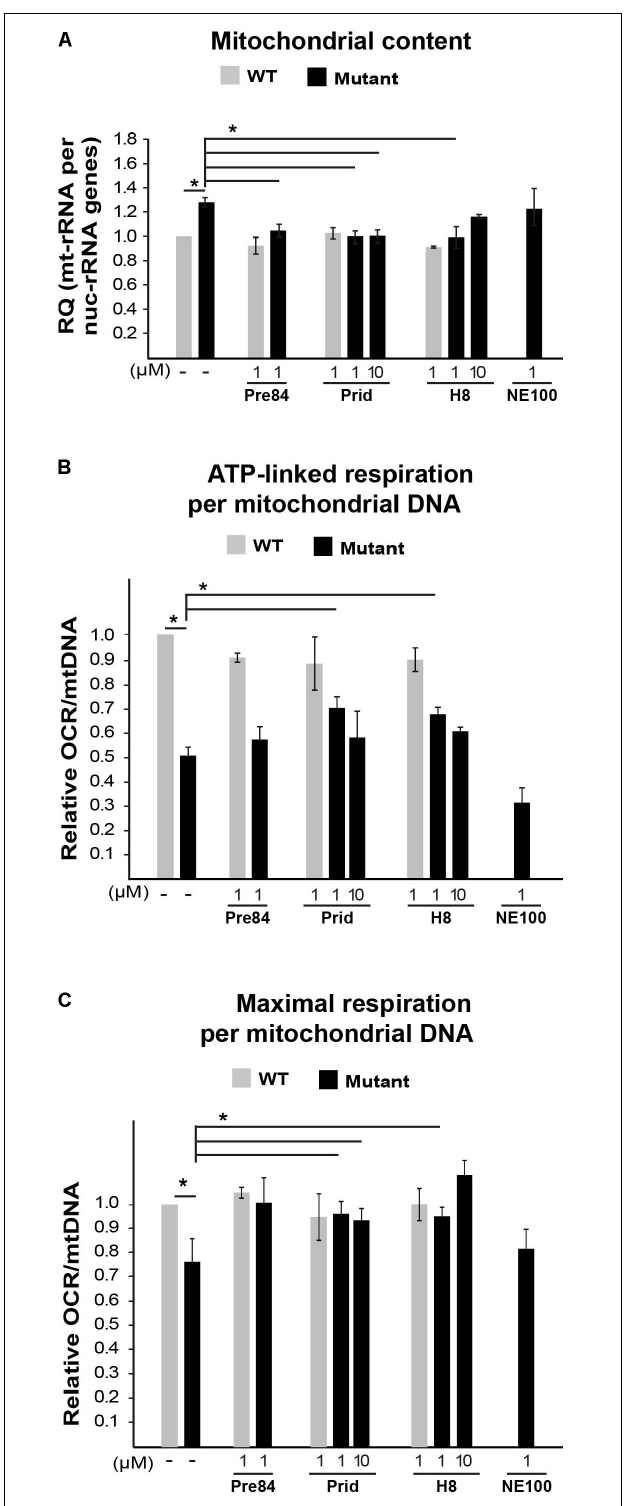
FIGURE 5 | Effect of S1R binders on mitochondrial abundance and performance in mutant MEFs. (A) qPCR analysis of mitochondrial 12S rRNA and nuclear 18S rRNA genes in WT (gray) and Mut (black) MEFs incubated or